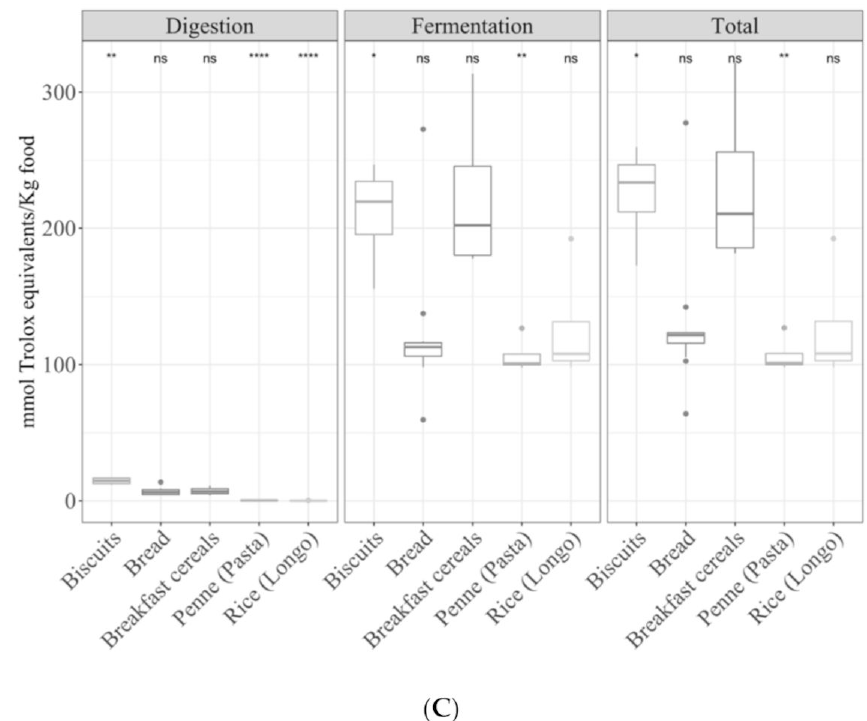
Figure 5. Antioxidant capacity of digested-fermented cereals depending on the sample type (( A ) TEAC DPPH , ( B ) for Folin–Ciocalteu and ( C ) TEAC FRAP ). Statistical analysis was performed through ANOVA using the mean of all food groups as the reference value. Statistic labels: *: p < 0.05, **: p < 0.01, ***: p < 0.001, ****: p < 0.0001, ns: not